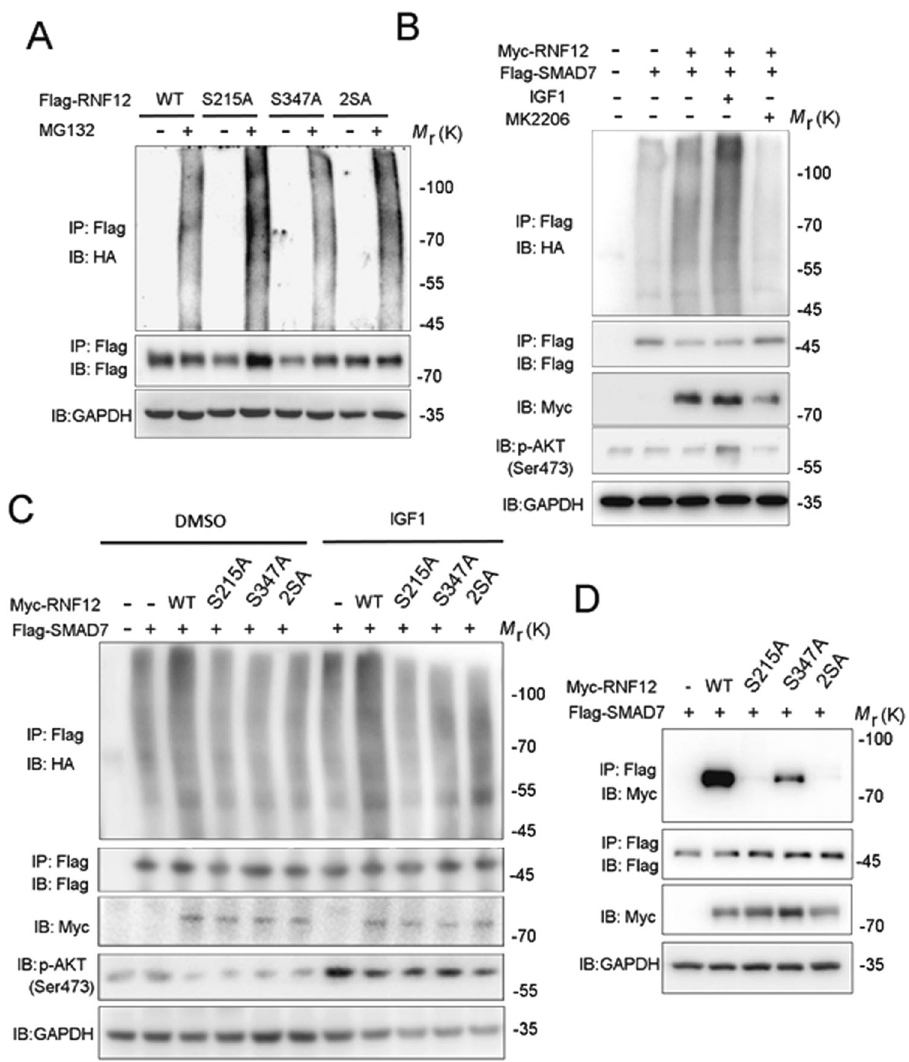
regulates RNF12-mediated ubiquitination of SMAD7. Immunoblot analysis of whole-cell lysate and immunoprecipitations derived from HA- Ub-expressing HEK293T cells transfected with Flag-SMAD7 and Myc-RNF12, treated with IGF-1 (200 ng/mL) or MK2206 (5 μ M) for 8 h. C RNF12 mutations attenuated ubiquitination of SMAD7 by RNF12. Immunoblot analysis of whole-cell lysates and immunoprecipitation derived from HA-Ub-expressing HEK293T cells transfected with Flag-SMAD7 and Myc-RNF12 mutants. D RNF12 S215A mutation attenuated interaction between RNF12 and SMAD7. HEK293T cells were co-transfected with Flag-SMAD7 and Myc-RNF12 wild-type or mutant plasmids. At 48 h post- transfection, cell lysates were harvested and subjected to anti-FLAG immunoprecipitation followed by anti-Myc western blotting. Protein expression was con fi rmed by western blotting using total cell